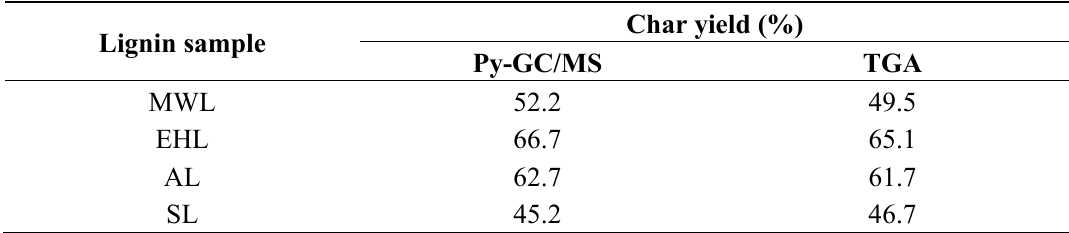
Table 3. Comparison char yields by using Py-GC/MS and TGA at 450 °C a